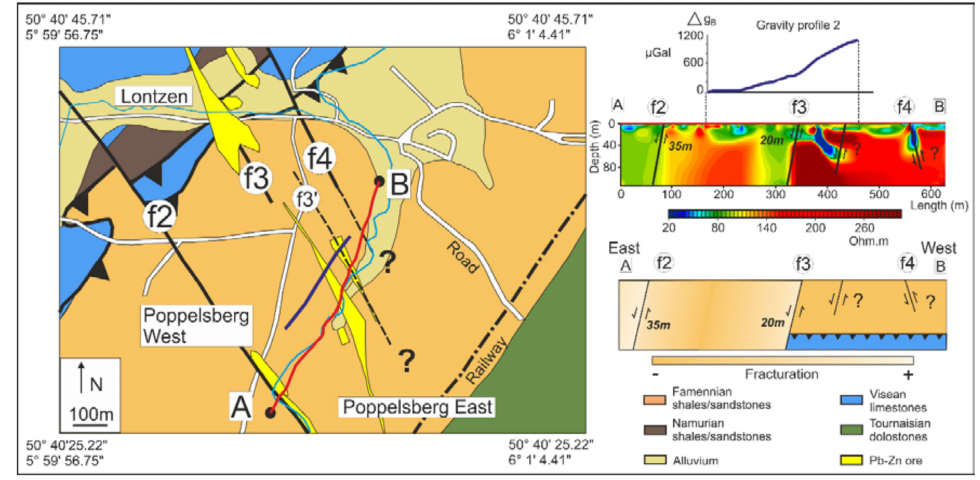
Figure 11. Conceptual model ( right down ) from gravity and ERT observation along Profile A–B oriented SSW–NNE (geological map modified from Laloux et al.